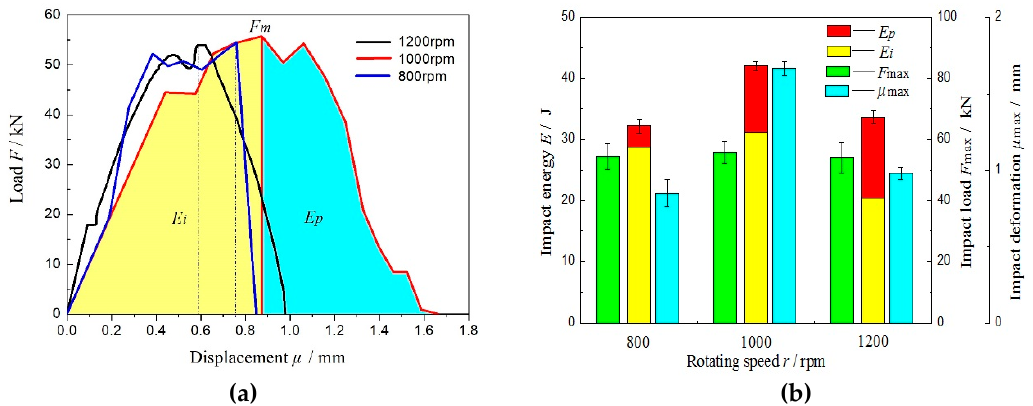
Figure 13. Load-displacement curves ( a ) and histogram of impact properties ( b ) of the dissimilar Al/steel keyhole-free FSSW joint.